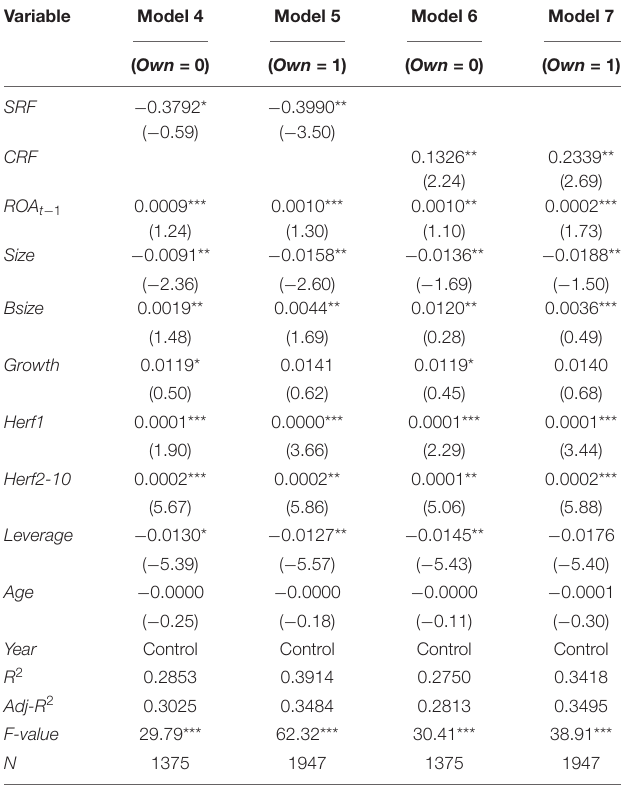
TABLE 4 | Impact of property right background on the relationship between board faultlines and innovation strategy